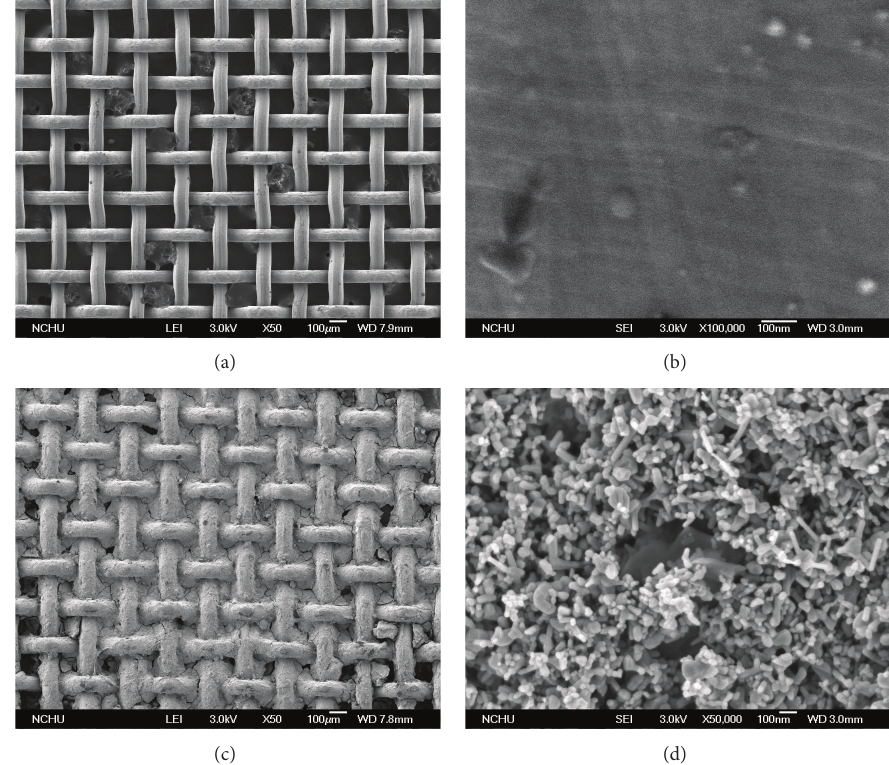
Figure 1: The morphology of ZnO powder coated on steel mesh at 150 ∘ C was identified by a JEOL 6330CF field emission scanning electron microscope (FESEM). (a) Bare steel mesh, 50 times enlargement. (b) Bare steel mesh, 100,000 times enlargement. (c) ZnO-coated steel mesh, 50 times enlargement. (d) ZnO-coated steel mesh, 50,000 times